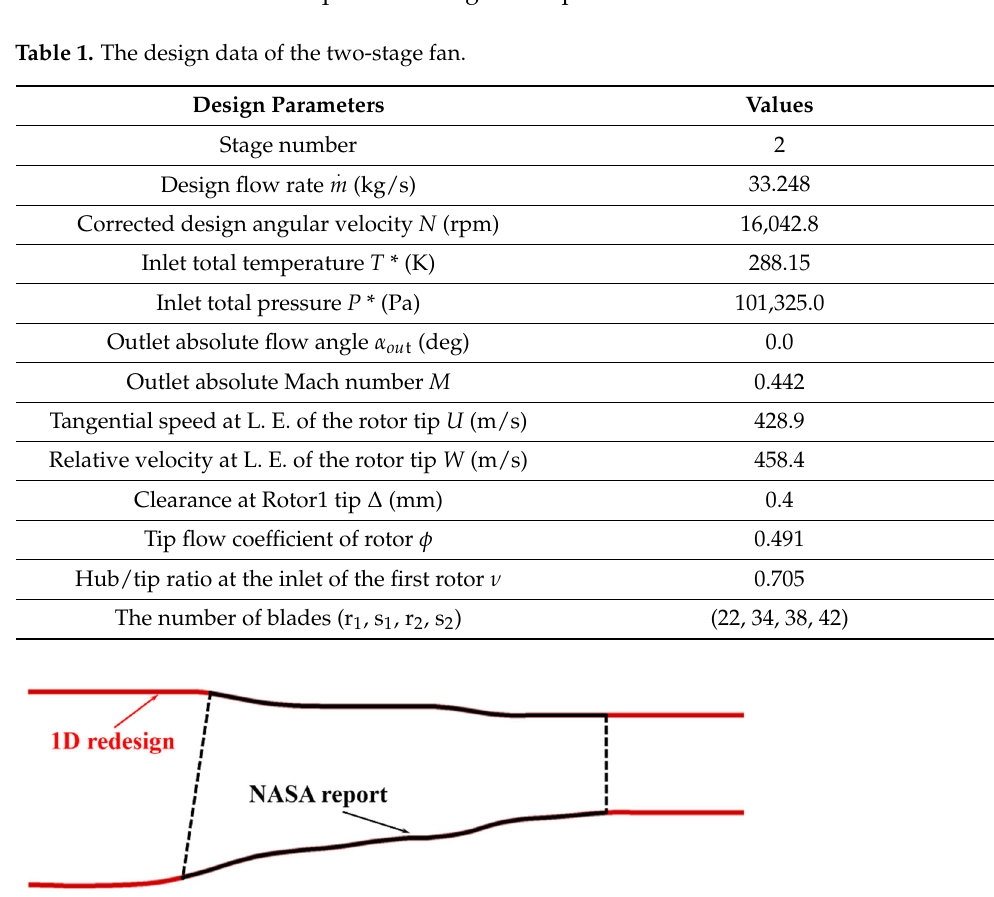
Figure 1. The end wall profile of the 1D design result.